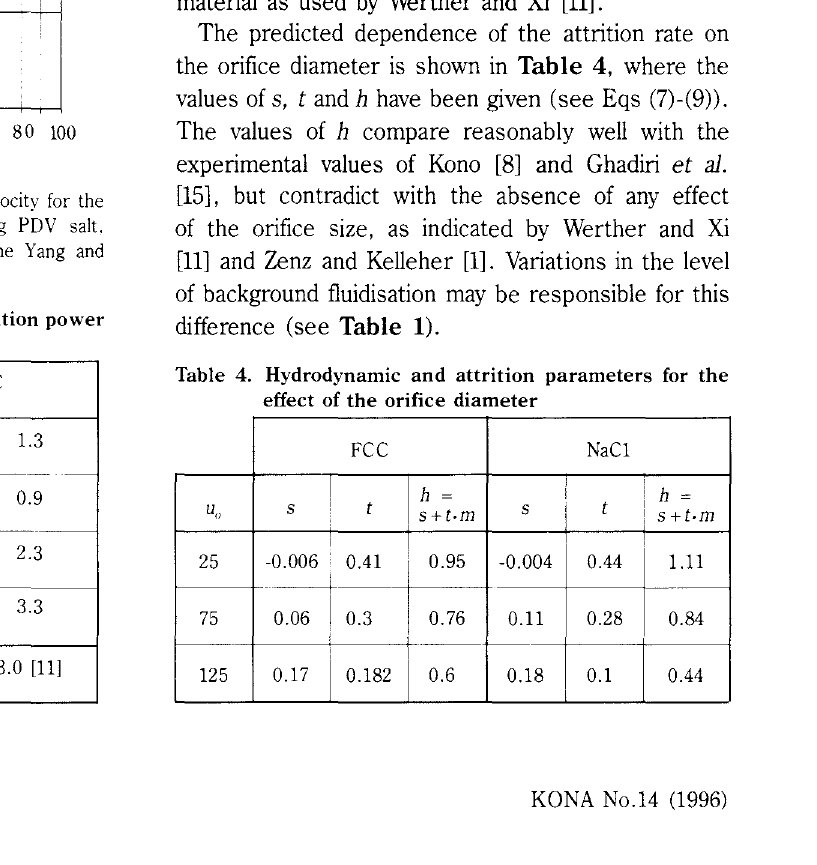
Fig. 12 Predication of particle velocity as a function of orifice velocity from a 1.0 mm orifice in a fluidised bed of NaCI.